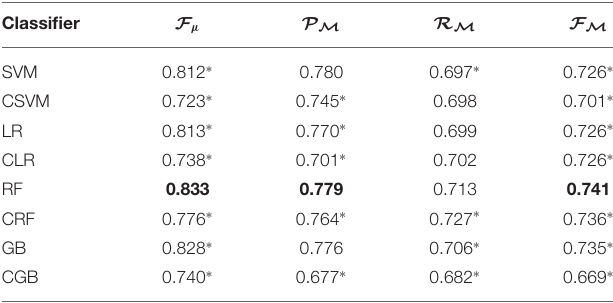
TABLE 2 | Results of different classifiers applied to 56 extracted features based on 10-fold cross